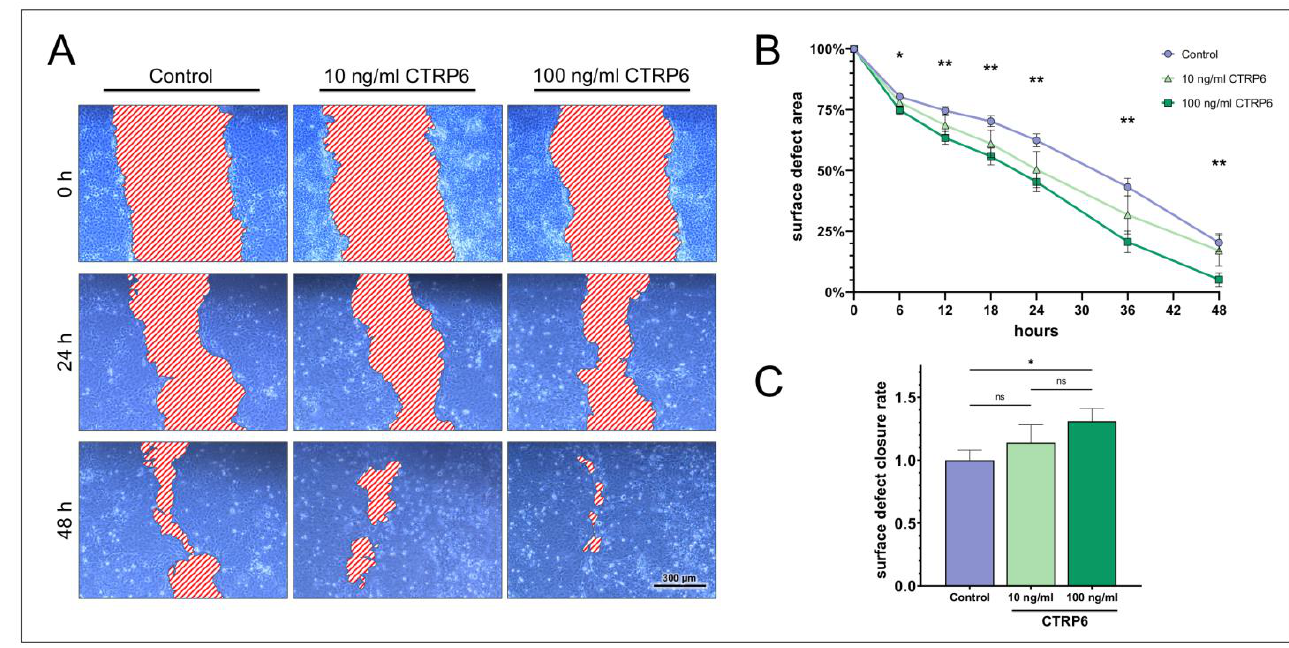
Figure 5. Scratch assays show the dose-dependent impact of CTRP6 on surface defect closure in human corneal epithelial cells (HCE). ( A ) After performing the initial scratch, HCE cells were stimulated with 0, 10, or 100 ng/mL recombinant human CTRP6 for 48 h. The surface defect was measured in a representative segment of a scratch ( n = 9) at different time points and compared to untreated cells (control). ( B ) Relative surface defect area ± SEM over time. The graph shows a significant decrease in the relative surface defect area in cells treated with 100 ng/mL CTRP6 compared to the control (two-way ANOVA; * p < 0.05; ** p < 0.01). Treatment with 10 ng/mL CTRP6 had no significant effect on the surface defect area when compared to the control (two-way ANOVA; p > 0.05). ( C ) Fold-increase in the surface defect closure rate. Bars represent mean ± SEM. 100 ng/mL CTRP6 increased the relative surface defect closure rate significantly compared to the control (one-way ANOVA; * p < 0.05), while 10 ng/mL CTRP6 was ineffective (one-way ANOVA; ns = not significant, p > 0.05). The difference in the surface defect closure rate between HCE cells treated with 10 ng/mL and 100 ng/mL CTRP6 was not significant (one-way ANOVA; ns = not significant, p >